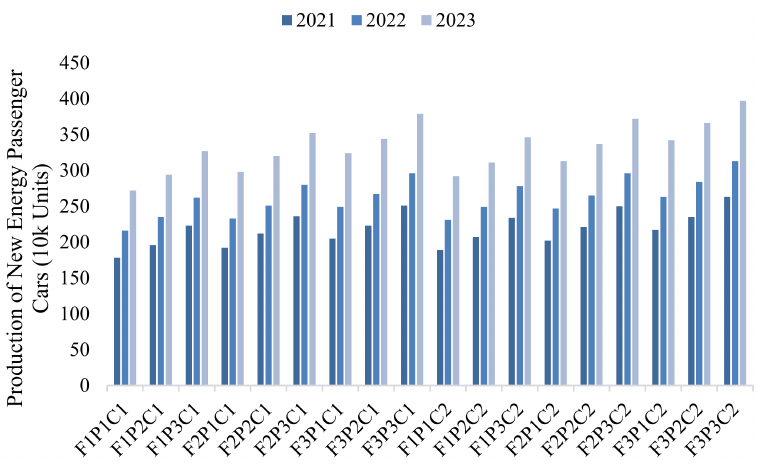
Figure 2. Results of Production Demand of New Energy Passenger Cars 2021 through